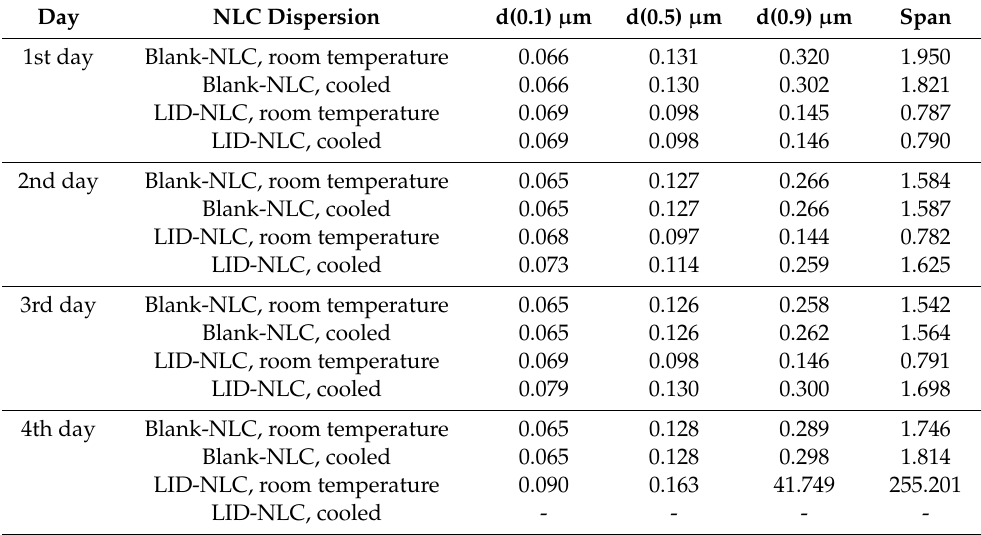
Table 3. Particle size of nanostructured lipid carrier (NLC) dispersions stored at different conditions.